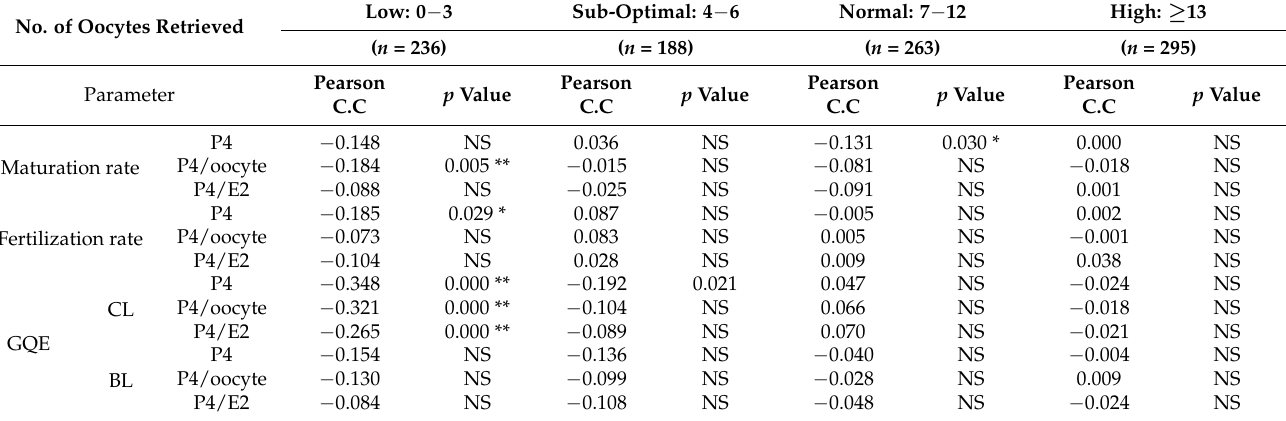
Table 4. Correlation analysis of parameters related to P4, P4/oocyte and P4/E2 according to the number of retrieved